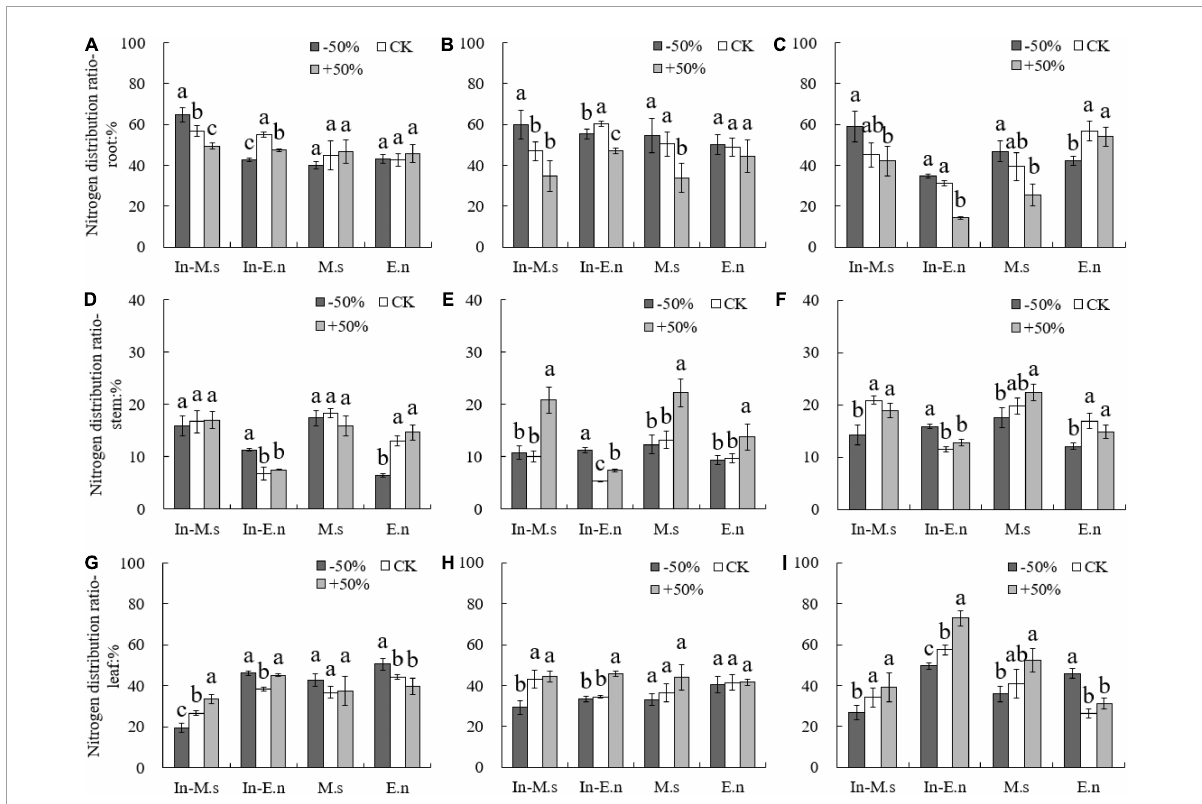
FIGURE6 Effect of water on nitrogen distribution in roots, stems, and leaves of different forages ( A,D,G : 2015; B,E,H : 2016; C,F,I : 2017). Different lowercase letters show significant differences under different water levels ( P < 0.05).